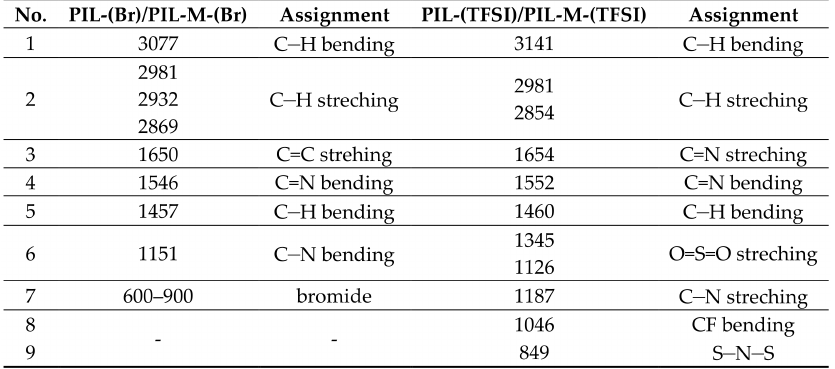
Table 2. IR-ATR observed wavelengths, in cm − 1 , of the absorption bands detected in the spectra